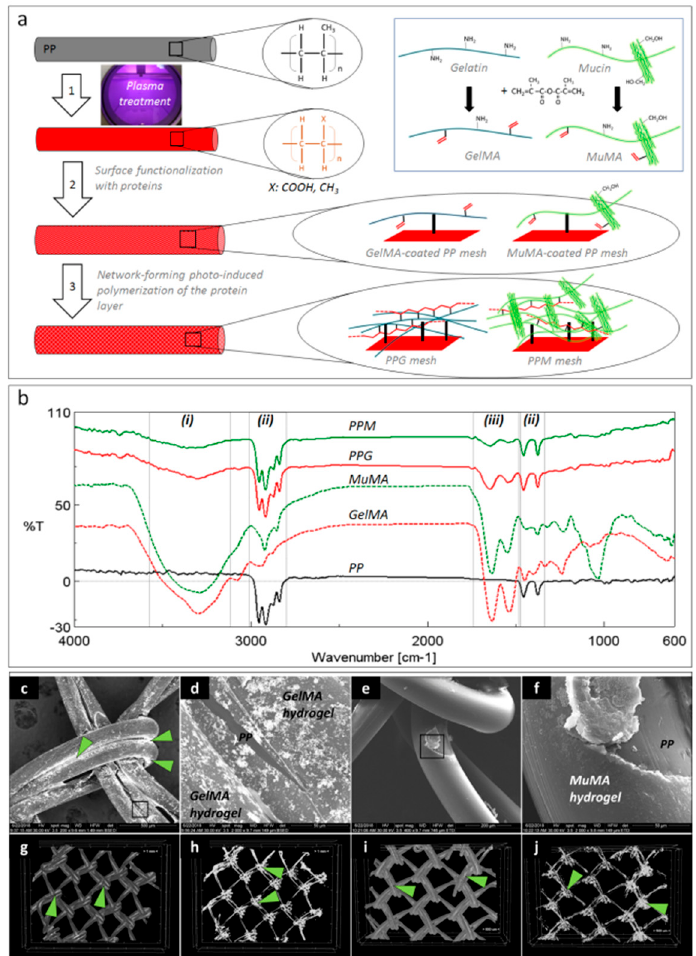
Figure 1. Coatings’ characterization. ( a ): Schematic representation of the three-step procedure used for the surface functionalization of PP meshes: 1—plasma treatment, 2—functionalization with protein analogues GelMA and MuMA (synthesis in inset), 3—generation of polymer-based hydrogels as coatings for the PP fibers; ( b ): FTIR spectroscopy (ATR): solid black—unmodified PP, dashed red and green—methacryloyl derivatives of gelatin and mucin, GelMA and MuMA, solid red and green—hydrogel-coated meshes, PPG and PPM with characteristic peaks for proteins (i and iii) and PP (ii); ( c – f ): SEM micrographs demonstrating the homogeneity of the hydrogel coating; ( c ): PP fibers are coated with GelMA, Ag-staining is visible under BSED mode; ( d ): microstructural detail corresponding to the selected area in panel c , GelMA hydrogel uniformly covers one PP fiber, while PP substrate is visible in a hydrogel surface fracture (BSED mode); ( e ): MuMA hydrogel uniform coatings at the surface of PP fibers (ETD mode); ( f ): microstructural detail corresponding to the selected area in panel e (ETD); ( g – j ): micro-CT images: green arrows point Ag agglomerations concentrated at the nodes of the mesh (( h , j )—micro-CT images of the isolated protein coating).